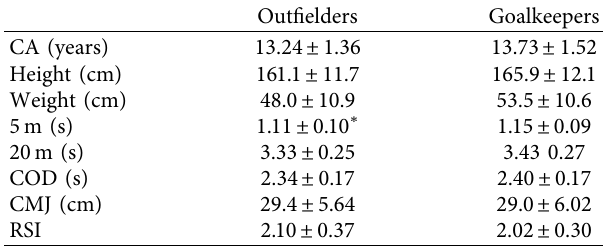
Table 8: Descriptive variables and comparisons of positional means ± SD in physical performance tests between outfielders and